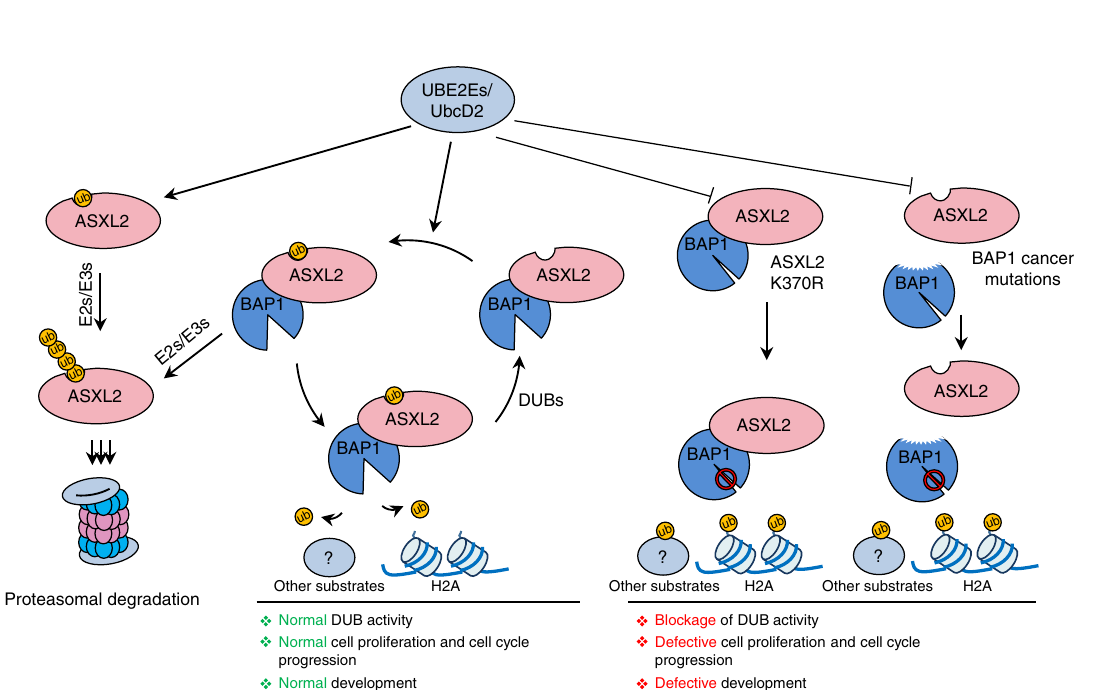
Fig. 9 Expression of ASXL2 K370R reduces mammalian cell proliferation. a Enforced expression of ASXL2 K370R decreases cellular proliferation. U-2 OS cells were transduced with different amounts of lentiviral suspensions produced using ASXL2 or ASXL2 K370R constructs. Cells were selected by puromycin and harvested for immunoblotting (top panel). Equal numbers of puromycin-selected cells were plated for colony formation assay (CFA) (bottom panel). n = 2 biological replicates. b The cells infected in a , were treated with nocodazole for FACS analysis at the indicated times. Note that ( + 2×) refers to transduction of cells with twice the amount of virus we normally use for Myc-ASXL2, and ( − 2×) refers to transduction of the cells with two times less the amount of viruses we normally use for ASXL2 370R. This adjustment was conducted to correct for the expression levels usually higher for ASXL2 K370R. n = 2 biological replicates. c , d Normal diploid fi broblast IMR90 cells were transduced with viral expression constructs for ASXL2 or ASXL2 K370R. Cells were selected by puromycin and equal numbers were plated for phase contrast pictures ( c ) or cell counts ( d ). Scale bar: 50 µ m for panel c . n = 2 biological replicates. (Exp.1 and Exp.2). e siRNA depletion of ASXL2 decreases cellular proliferation. U-2 OS cells were transfected with NT siRNA control or siRNA for ASXL2 . Equal numbers of puromycin-selected cells were plated for CFA (left panel). Cells were treated with nocodazole for FACS analysis (right panel). f siRNA depletion of UBE2E3 decreases cellular proliferation. U-2 OS cells were transfected with individual siRNA constructs as indicated. Cells were plated for viability measurement using MTT assay. n = 3 biological replicates. Error bars represent s.d. (mean ± SD). g , h Inactivation of UBE2E3 locus decreases cellular proliferation. Schematic representation for gRNAs targeting the UBE2E3 locus ( g top panel). U-2 OS cells were transduced with different lentiviral CRISPR/Cas9 constructs, selected by puromycin and harvested for immunoblotting ( g bottom panel). n = 3 biological replicates. Equal numbers of puromycin-selected cells were plated for CFA ( h ). n = 2 biological replicates. i The cells selected as in h were treated with nocodazole for FACS analysis at the indicated time . n = 2 biological replicates. j Positive correlation of BAP1, ASXL2, and UBE2E3 protein